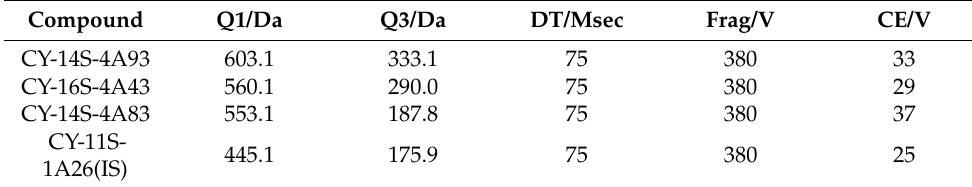
Table 8. Optimal MRM parameters for CY-14S-4A93, CY-16S-4A43, CY-14S-4A83, and